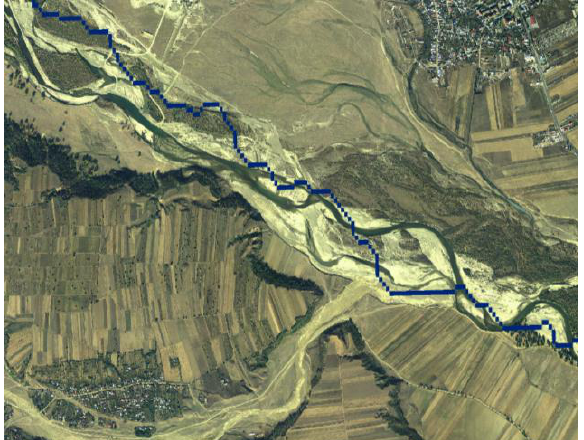
Figure 3. Obvious differences between the real path of the watercourse and the 30m SRTM delineated course